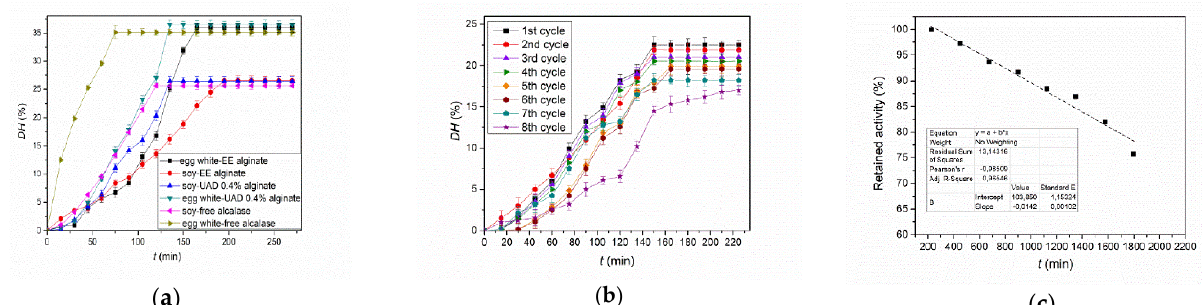
Figure 6. ( a ) Enzymatic progress curves of hydrolysis of egg white protein and soy protein isolate with alcalase immobilized on EE alginate beads and UAD 0.4% alginate. ( b ) The stability of the alcalase immobilized on UAD 0.4% alginate in repeated cycle using soy protein as substrate. Each cycle lasted for 225 min. Reaction condition: 1% ( w / w ) soy protein isolate aqueous solution (2.4 mg mL − 1 , protein content), 50 ◦ C, pH 8.0, stirring at 240 rpm. ( c ) Retained activity as a function of time.